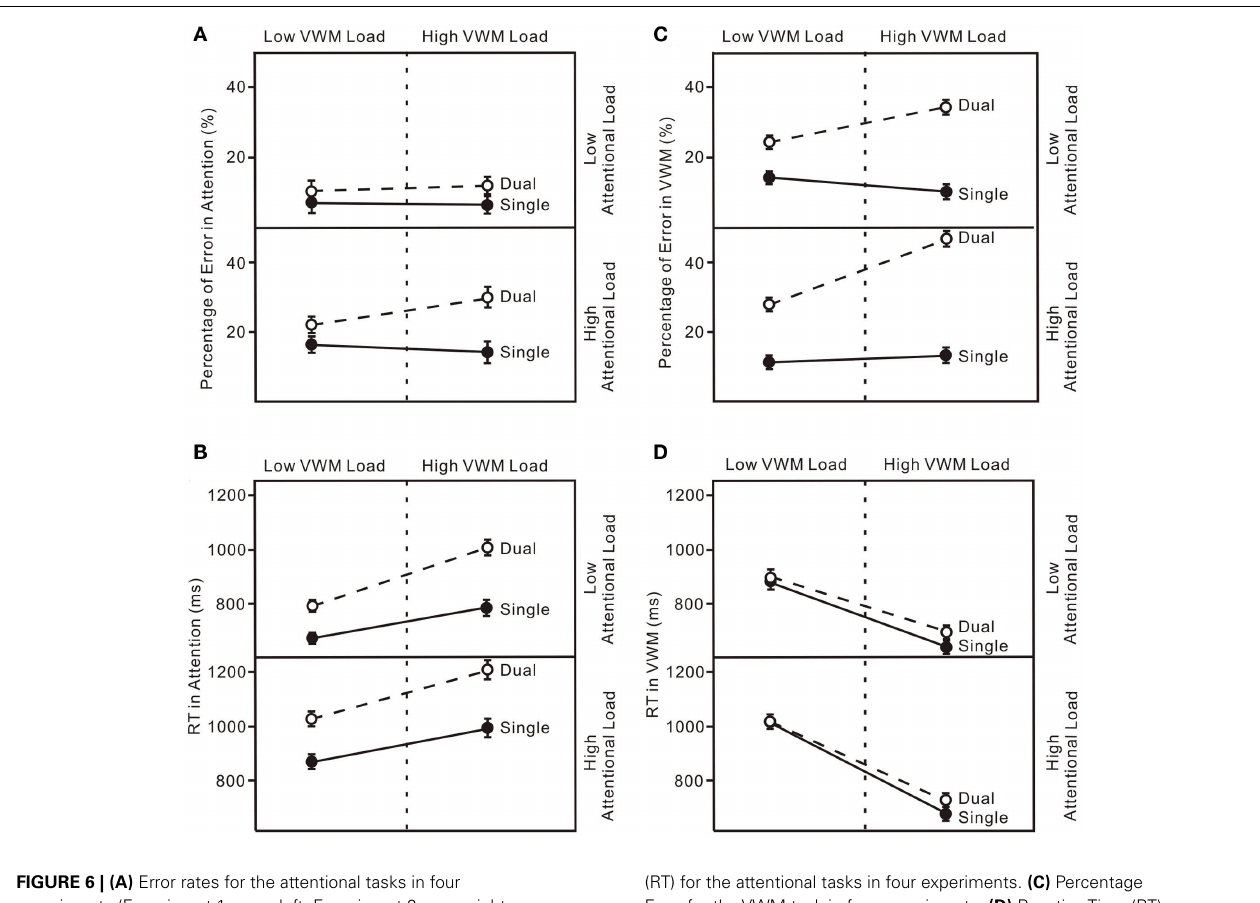
FIGURE 6 | (A) Error rates for the attentional tasks in four experiments (Experiment 1-upper left, Experiment 2-upper right, Experiment 3-lower left, Experiment 4-lower right). “Single” indicates the enumeration data for single-task trials and “Dual” indicates the enumeration data for dual-task trials. (B) ReactionTime